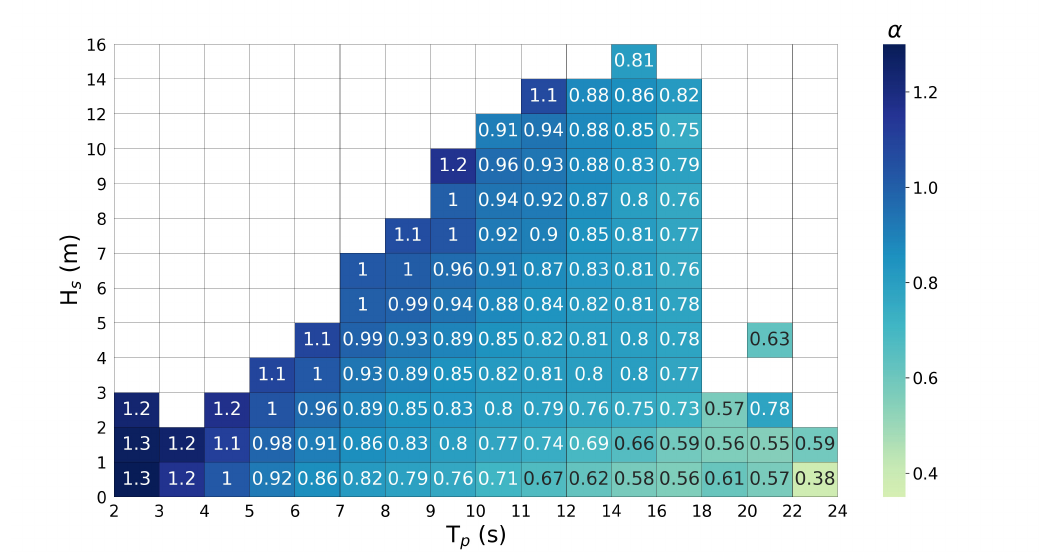
Figure 3. Distribution of the calibration coefficient α in classes of H s and T p resulting from the integration of observations in 17 NDBC wave buoys of the North-West Atlantic adapted from